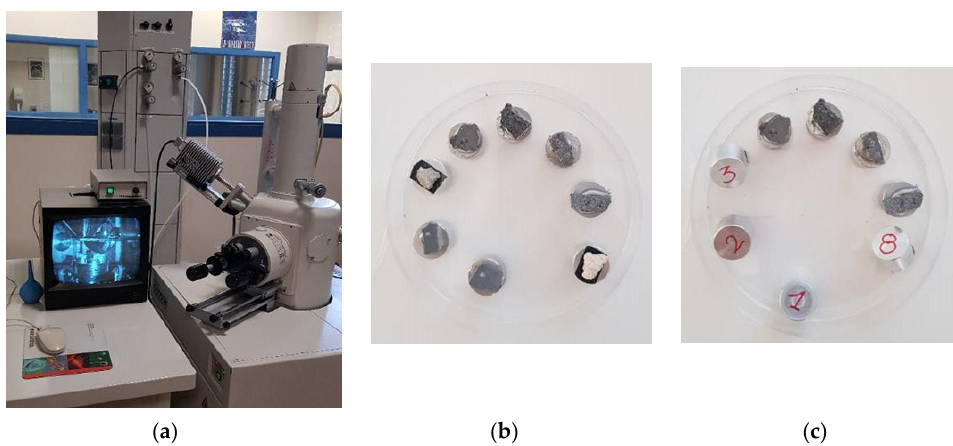
Figure 10. ( a ) S-3000N scanning electron microscope model Hitachi. ( b , c ) Samples mounted on the holder to be subjected to microstructural analysis.